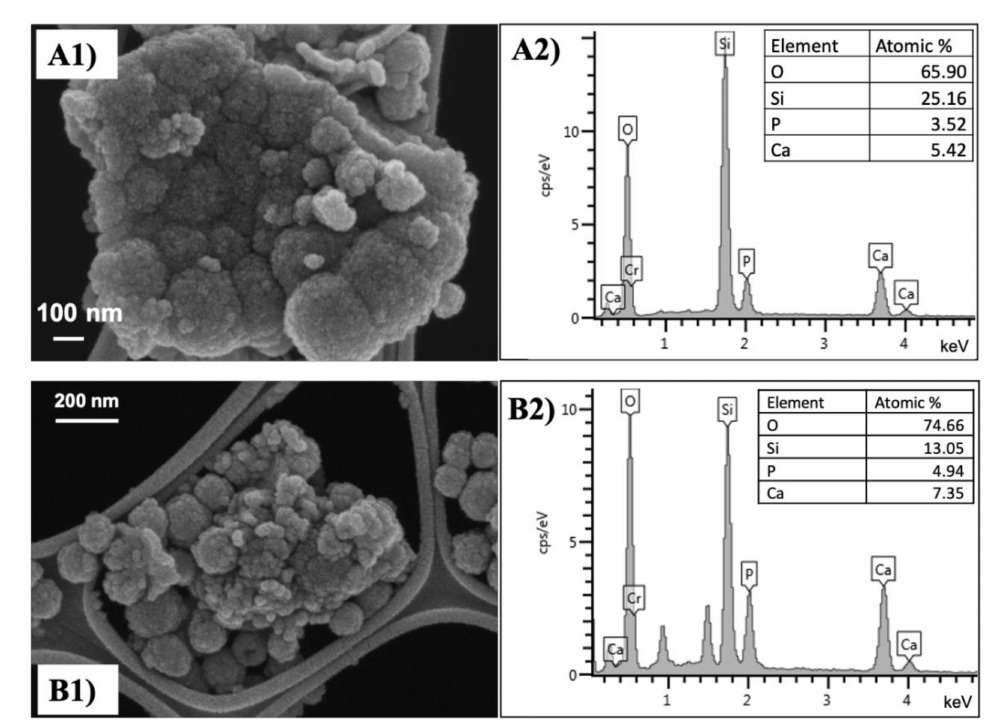
Figure 7. FE-SEM observation ( A1 ) and EDS spectrum ( A2 ) of Cu_SG_CAC_Ibu and FE-SEM observation ( B1 ) and EDS spectrum ( B2 ) of Cu_SG_CIC after 7 days of soaking in